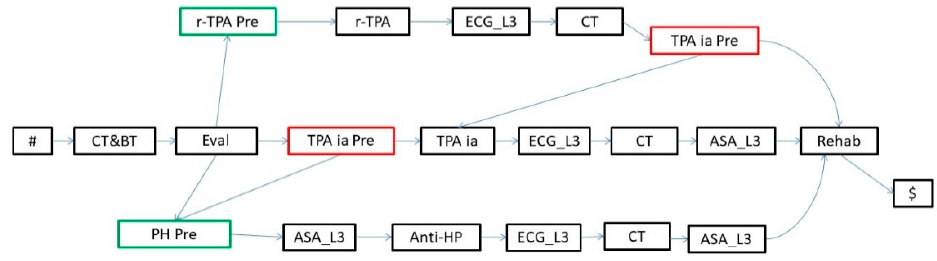
Figure 8. Process model interactively abstracted at level 3.